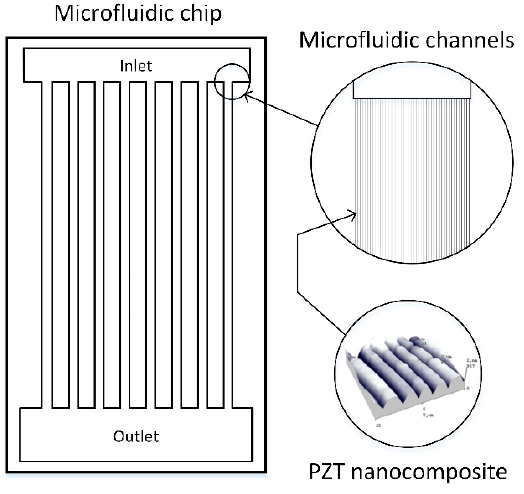
Figure 1. Schematic view of a microfluidic microchip.